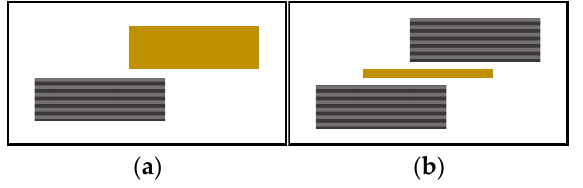
Figure 2. Single-lap welded joints for USW ( a ) welding of PEI on CF/PEEK and ( b ) welding of CF/PEEK on CF/PEEK with 250 µm thick PEI as energy director (yellow bars are for PEI, grey bars for CF/PEEK).